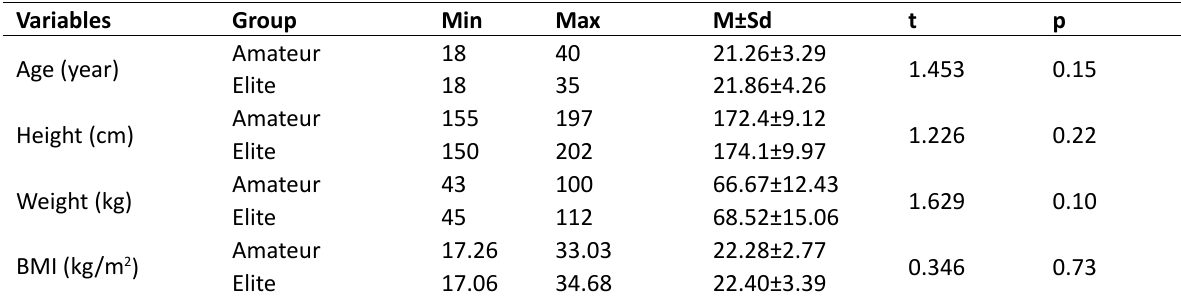
Table 1. Analysis of the general physical characteristics of athletes Variables